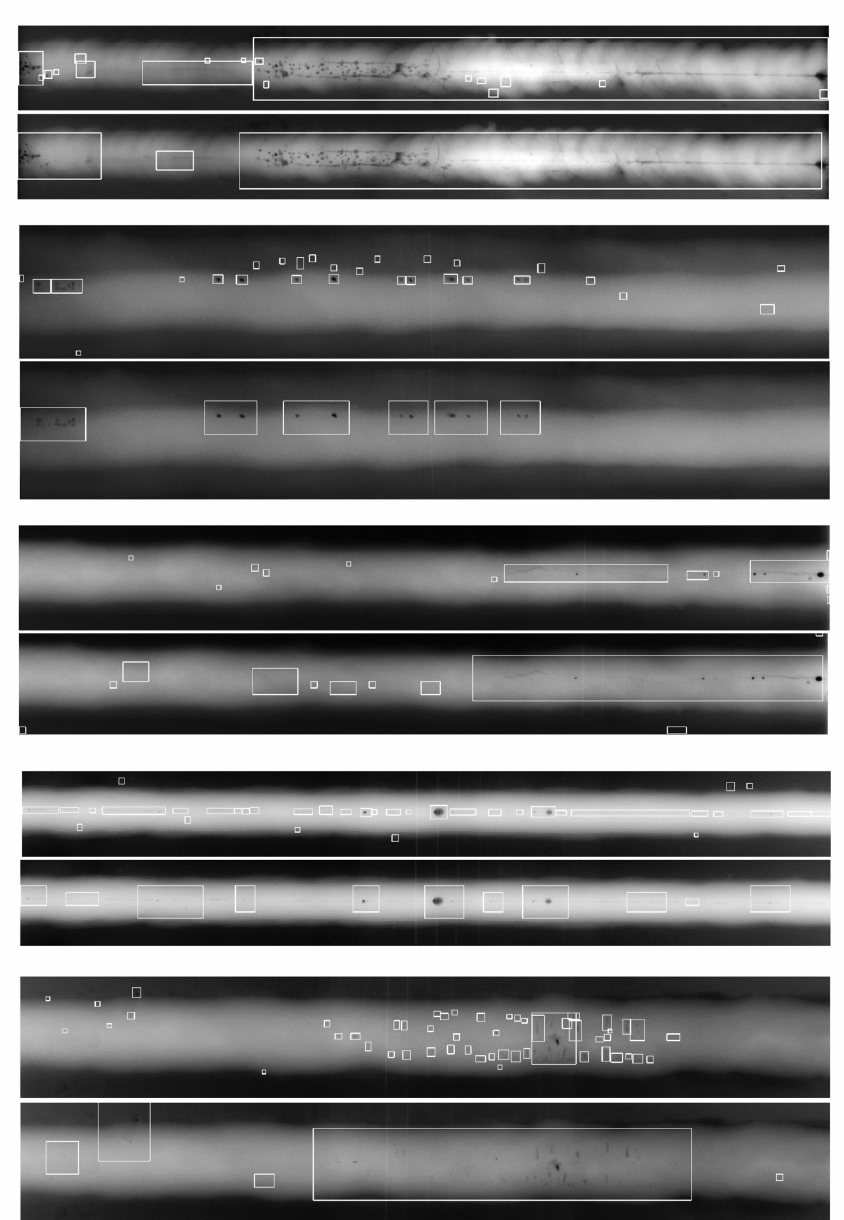
Figure 9. Five pairs of defect detection results of the proposed approach (GDXray dataset [24]). Each pair of results consists of the ground truth bounding boxes ( top ) and detected bounding boxes ( bottom